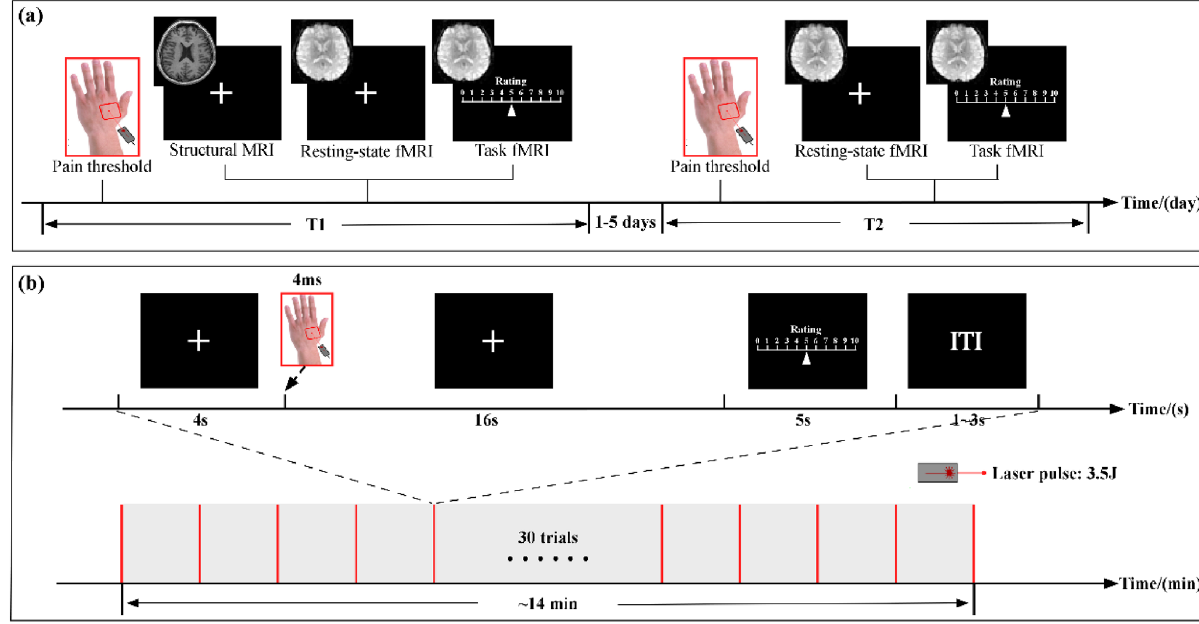
Figure 3. Experiment design and nociceptive stimulation. ( a ) Experimental design. ( b ) Task fMRI scan contained a single block of 30 trials with transient nociceptive stimuli. Each trial started with a 4-s fixation of the white cross-centered on the screen and followed by the delivery of a nociceptive stimulus. A visual cue presented 16 s after the nociceptive stimulus prompted the subjects to rate the perceived intensity within 5 s on the 0–10 NRS. The inter-trial interval varied randomly between 1 and 3 s. NRS, numerical rating scale. The MRI images were created by using the MRIcron software (v1.0.20190902, https ://www.nitrc .org/proje cts/mricr